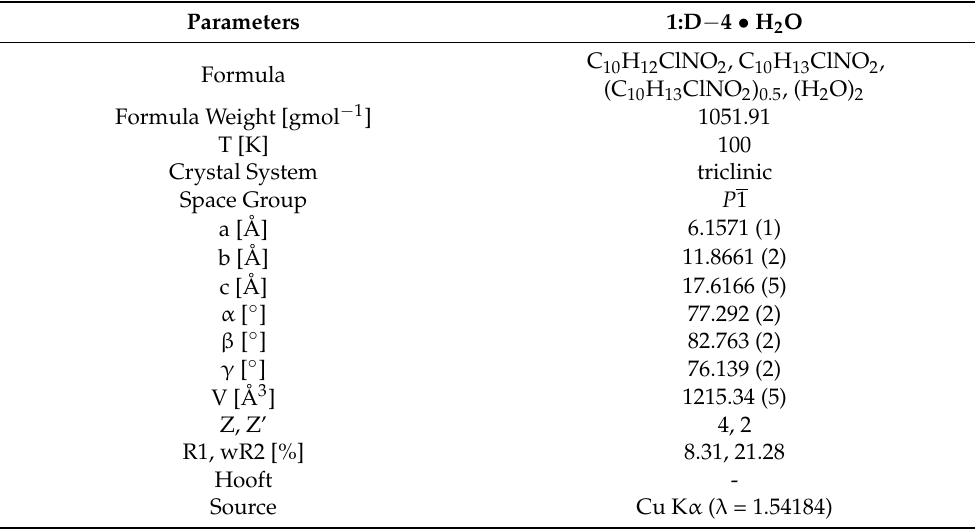
Table 4. Crystallographic data obtained by SCXRD measurements of 1:D − 4 • H 2 O .